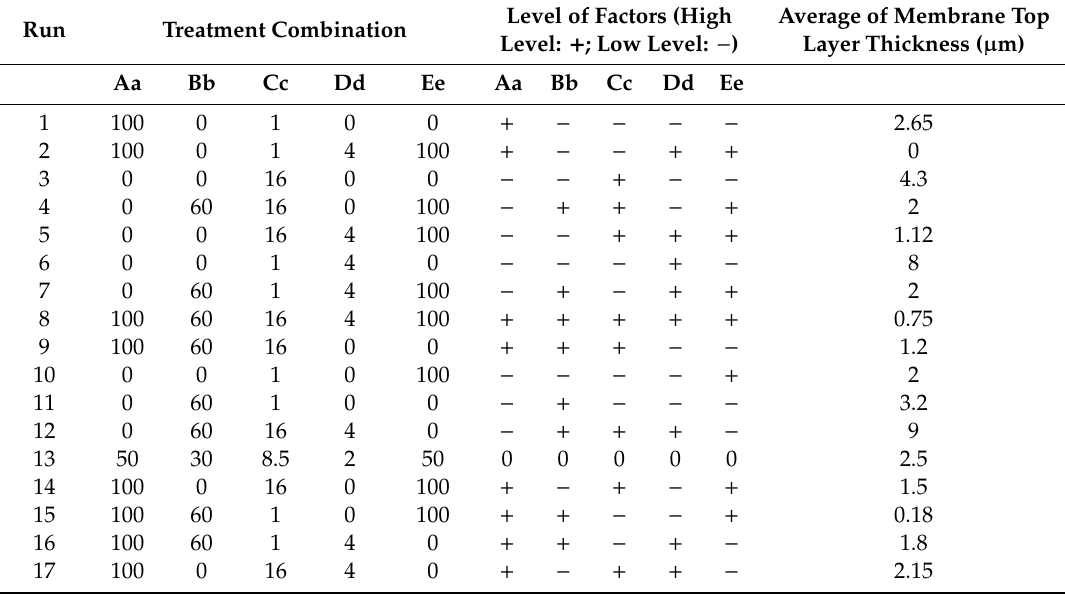
Table 2. One-half fractional factorial design (response: top layer